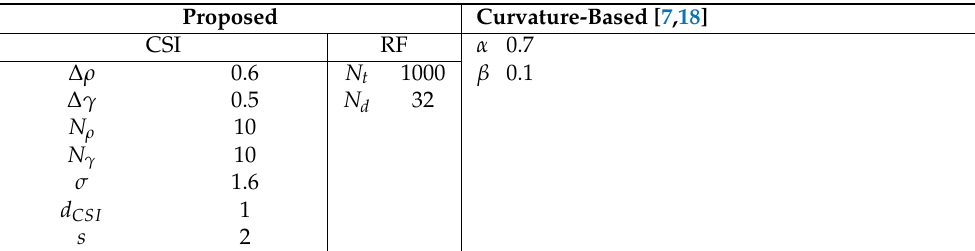
Table 5. Summary of parameters for comparative